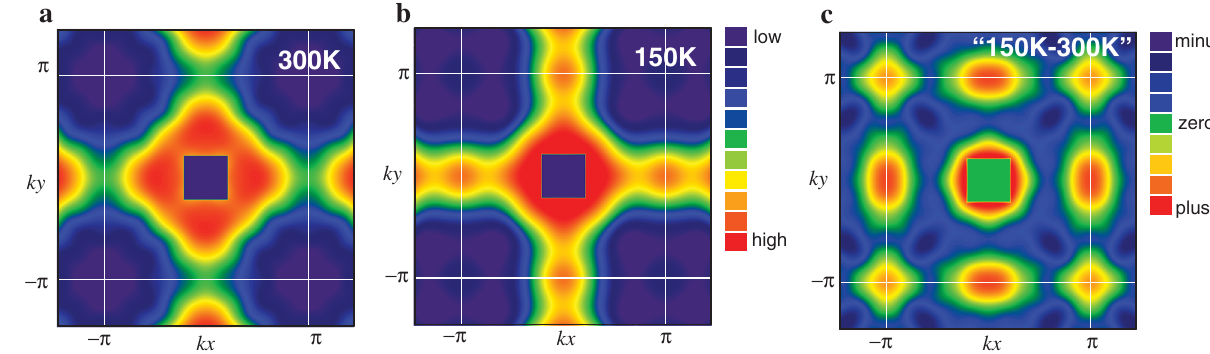
Fig. 1 Images of the momentum distribution function n (k) by high-resolution Compton scattering. Maps of n ( k ) in the fi rst Brillouin zone at 300 K ( a ) and 150 K ( b ) for La 2 − x Sr x CuO 4 with x = 0.08. The color scale represents the relative intensity. c The difference of n ( k ) between 300 K and 150